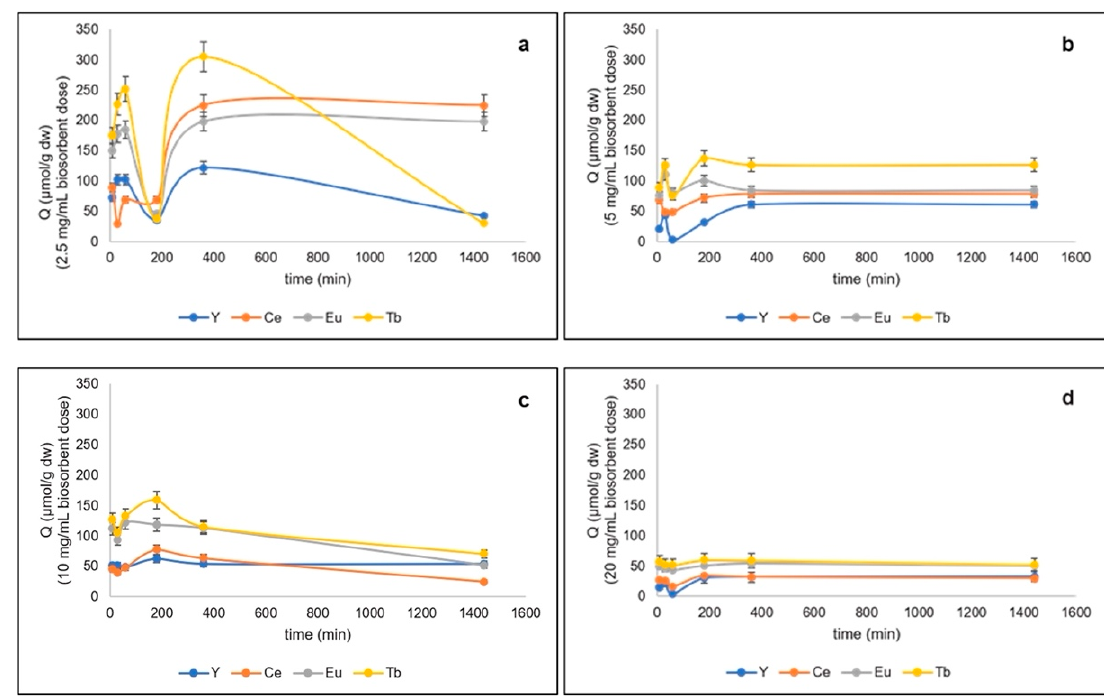
Figure 1. Total metals removed (µmol/g dw) from quaternary metal systems at pH 2.5 by freeze- dried algal biomass of G. sulphuraria ACUF427 at different doses of biosorbent: ( a ) 2.5 mg/mL, ( b ) 5 mg/ mL, ( c ) 10 mg/mL, and ( d ) 20 mg/mL after 10, 30, 60, 180, and 360 min of contact time. Table 1. Maximum adsorption capacity (µmol/g dw) from quaternary metal systems at pH 2.5 and 4.5 by freeze-dried algal biomass of G. sulphuraria ACUF427 at biosorbent dosage 2.5 mg/mL.